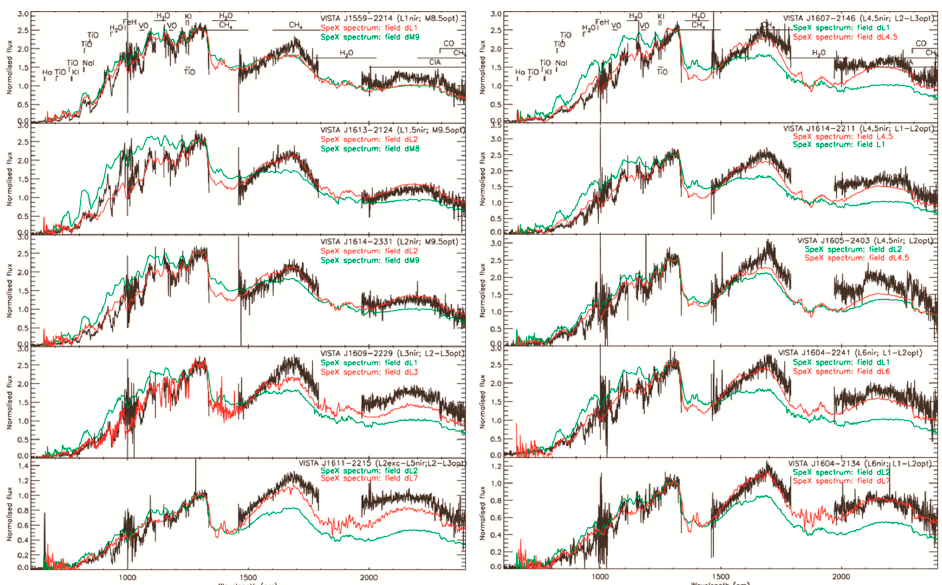
Figure 8. Normalized Osiris/GTC and X-shooter/VLT (smoothed) spectra of nine Upper Scorpius objects at the deuterium burning mass limit, compared to SpeX spectra of late M and early L field dwarfs. The overall spectral energy distribution matches best the infrared classification. Reproduced with permission from [139].